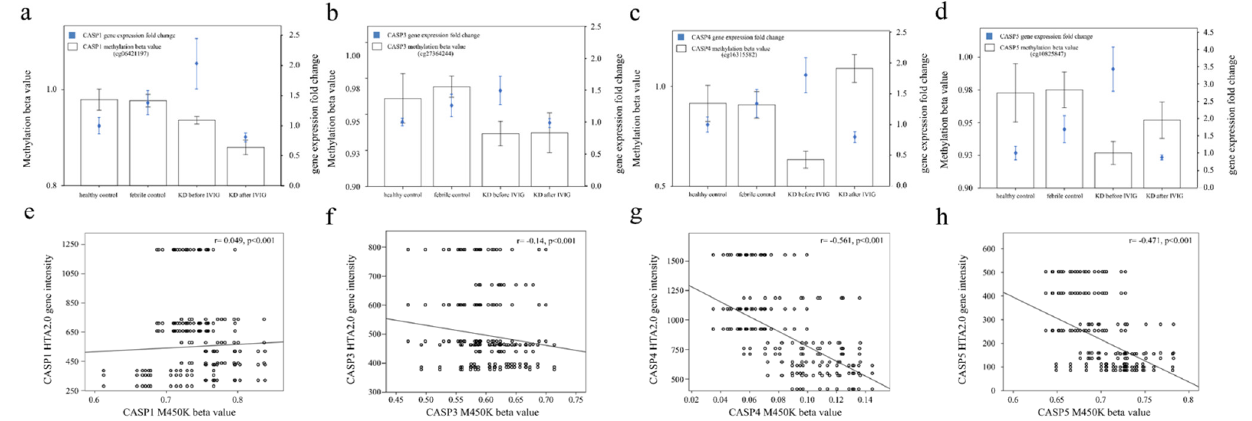
Figure 2. Integration of DNA methylation (M450K) and gene expression (HTA 2.0) profiles of CASP1 ( a ), CASP3 ( b ), CASP4 ( c ), and CASP5 ( d ). We used scatter plots ( e – h ) to represent the relationship between mRNA and rgw methylation levels of the CpG markers. The mRNA expression levels and cg16315582 of CASP4 ( g ) and cg10825847 of CASP5 ( h ) have a negative correlation in Kawasaki disease (KD) and control subjects (Pearson’s correlation coefficient r = −0.561 and −0.471, all p < 0.001). The histogram and curve are presented as mean ± standard error. We performed 10,000 re-samplings for each genes to extract pairs of gene intensity and CpG marker β values in each group. Therefore, we collected 40,000 pairs of gene intensity and CpG marker β values from the four groups. Using Partek, we conducted an ANOVA analysis and reported the p -values of the comparisons of interest. KD1: Kawasaki disease before IVIG treatment; KD3: Kawasaki disease > 3 weeks after IVIG treatment; FC: febrile control; HC: healthy control.